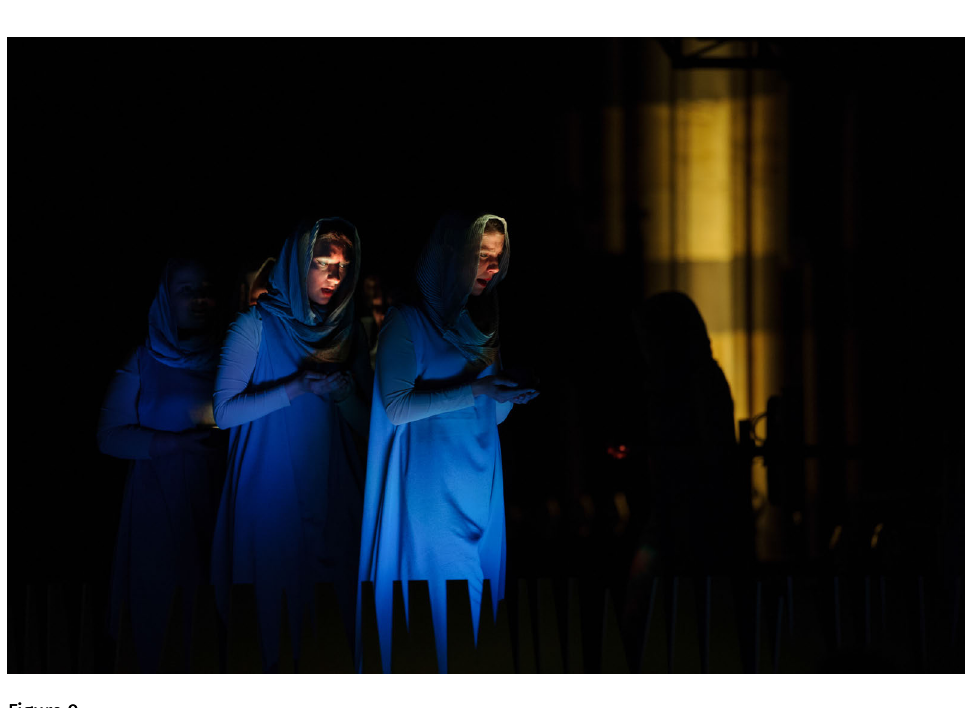
FFigigururee 8.8. The Crucifixion. (Photo: Sarah Walker)